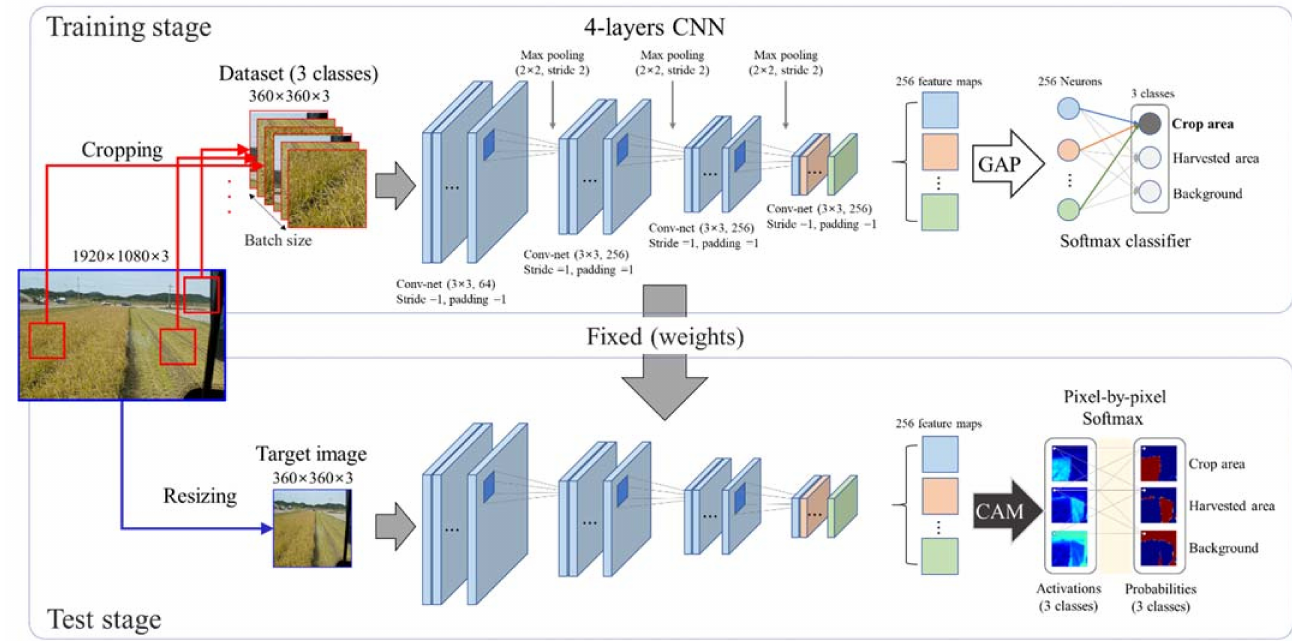
Figure 2. Proposed weakly supervised crop area segmentation. The upper and lower lines show the processes for partial image-based classification model training and full image-based area segmentation testing,